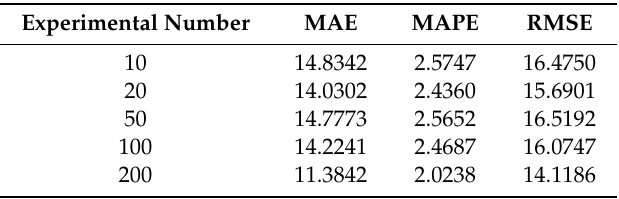
Table 3. Metrics of comparison experiments (Group 2).